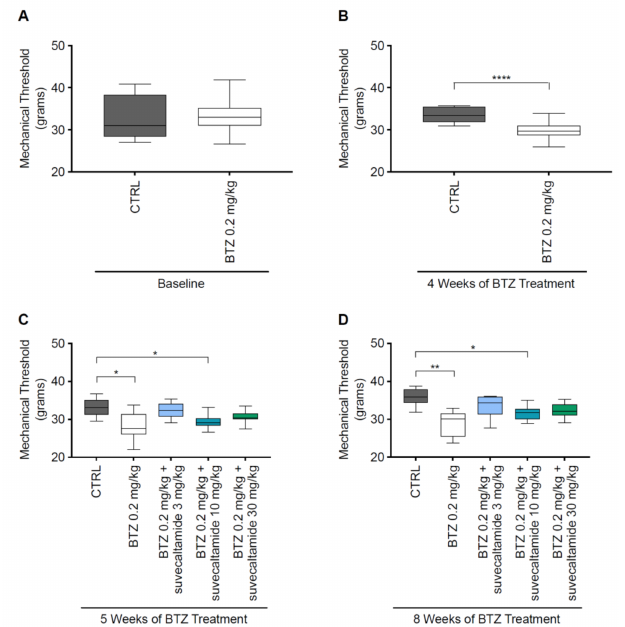
Figure 3. Mechanical threshold (MT). Evaluation of mechanical allodynia measured using a Dynamic Aesthesiometer Test during phase 1 (( A ) baseline and ( B ) 4 weeks) and phase 2 (( C ) 5 and ( D ) 8 weeks) in a rat model of BTZ-induced CIPN. BTZ—bortezomib; CIPN—chemotherapy-induced peripheral neurotoxicity; CTRL—untreated animals. * p < 0.05 vs. CTRL; ** p < 0.001 vs. CTRL; **** p = 0.0001 vs.